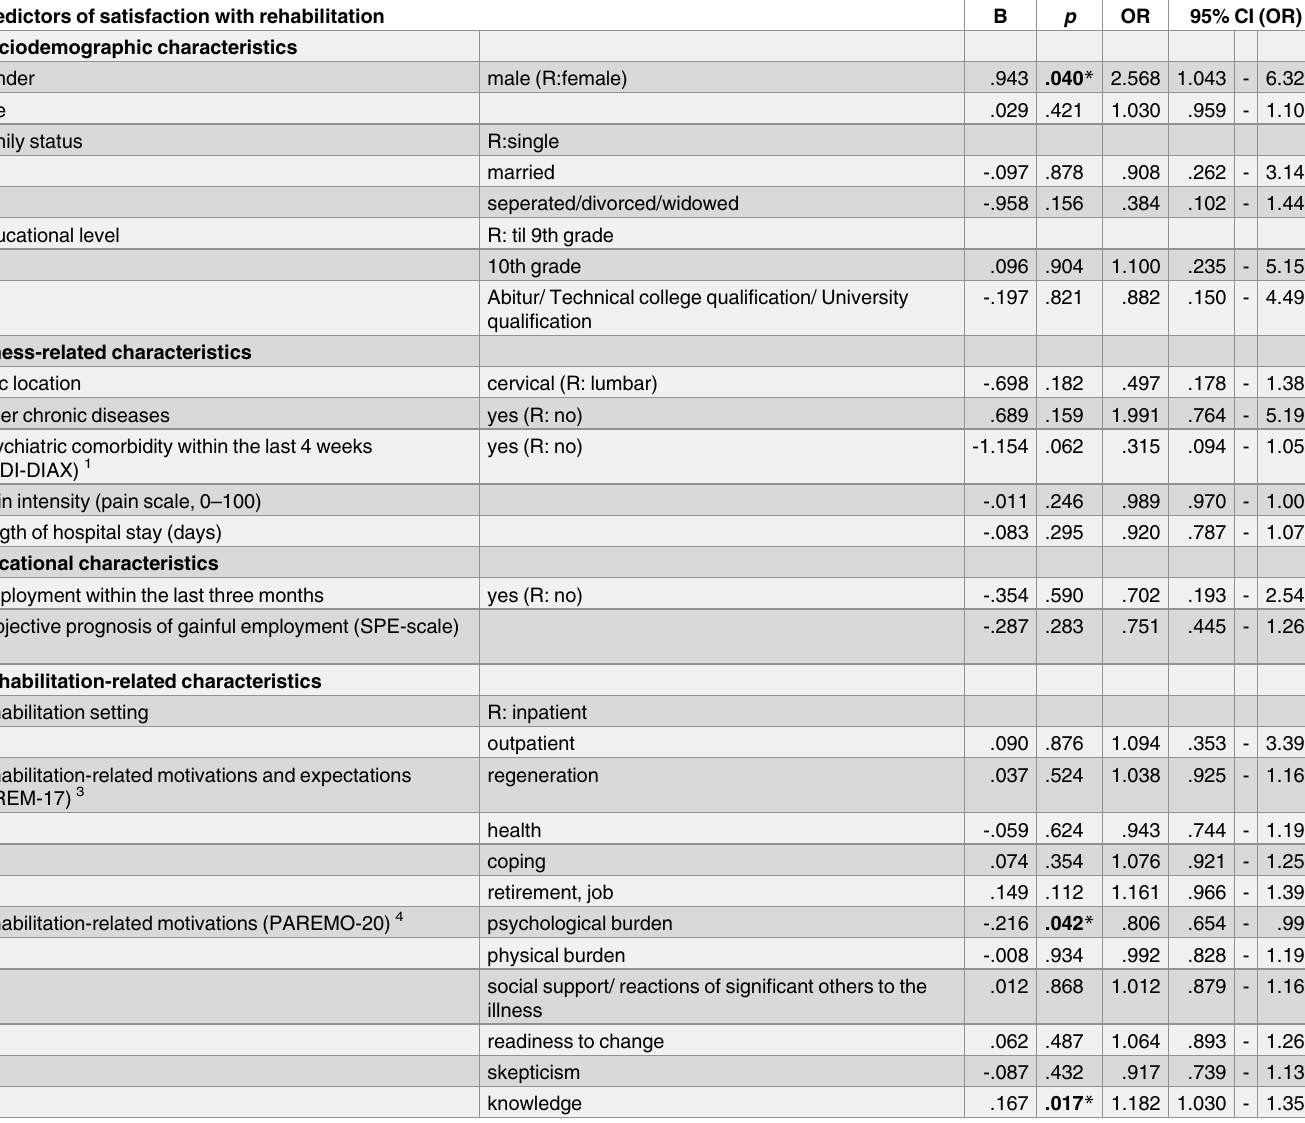
Table 5. Binary logistic regression model of factors associated with satisfaction with rehabilitation a three months after disc surgery (N = 424 b ). Predictors of satisfaction with